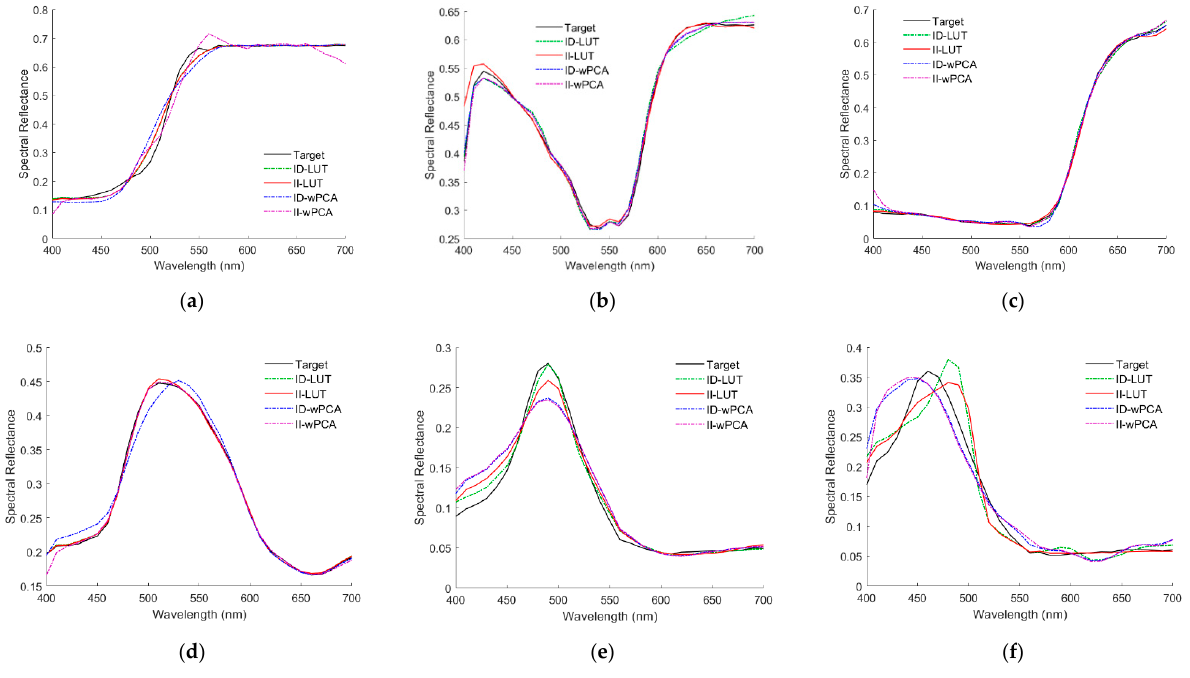
Figure 11. ( a – f ) showing the target spectra S Ref and recovered reflectance spectra S RefRec for the cases in Figure 10a,b, respectively. The spectrum reconstruction methods are shown in figures. Table 1. Munsell annotation of color chip and the β k value in Equation (13) for the cases shown in Figure 10a–f. The maximum β k value is shown in bold. The β k value corresponding to the normalized ARS neighborhood is indicated with “*”.